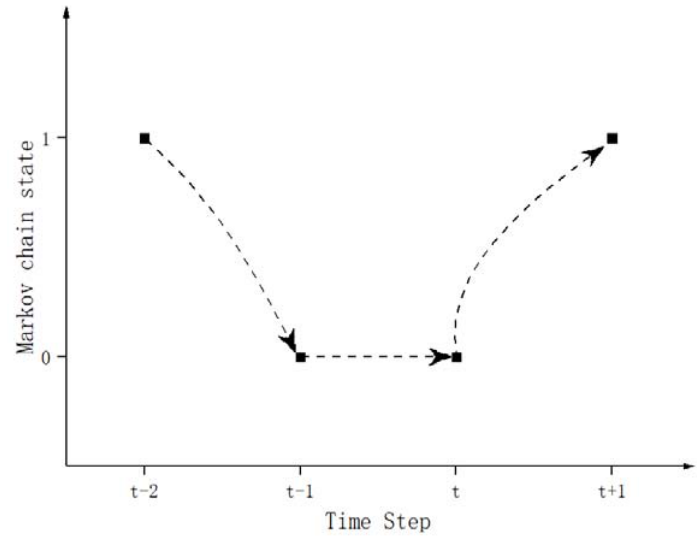
Figure 2. Status transfer of personnel in the office building at time t .